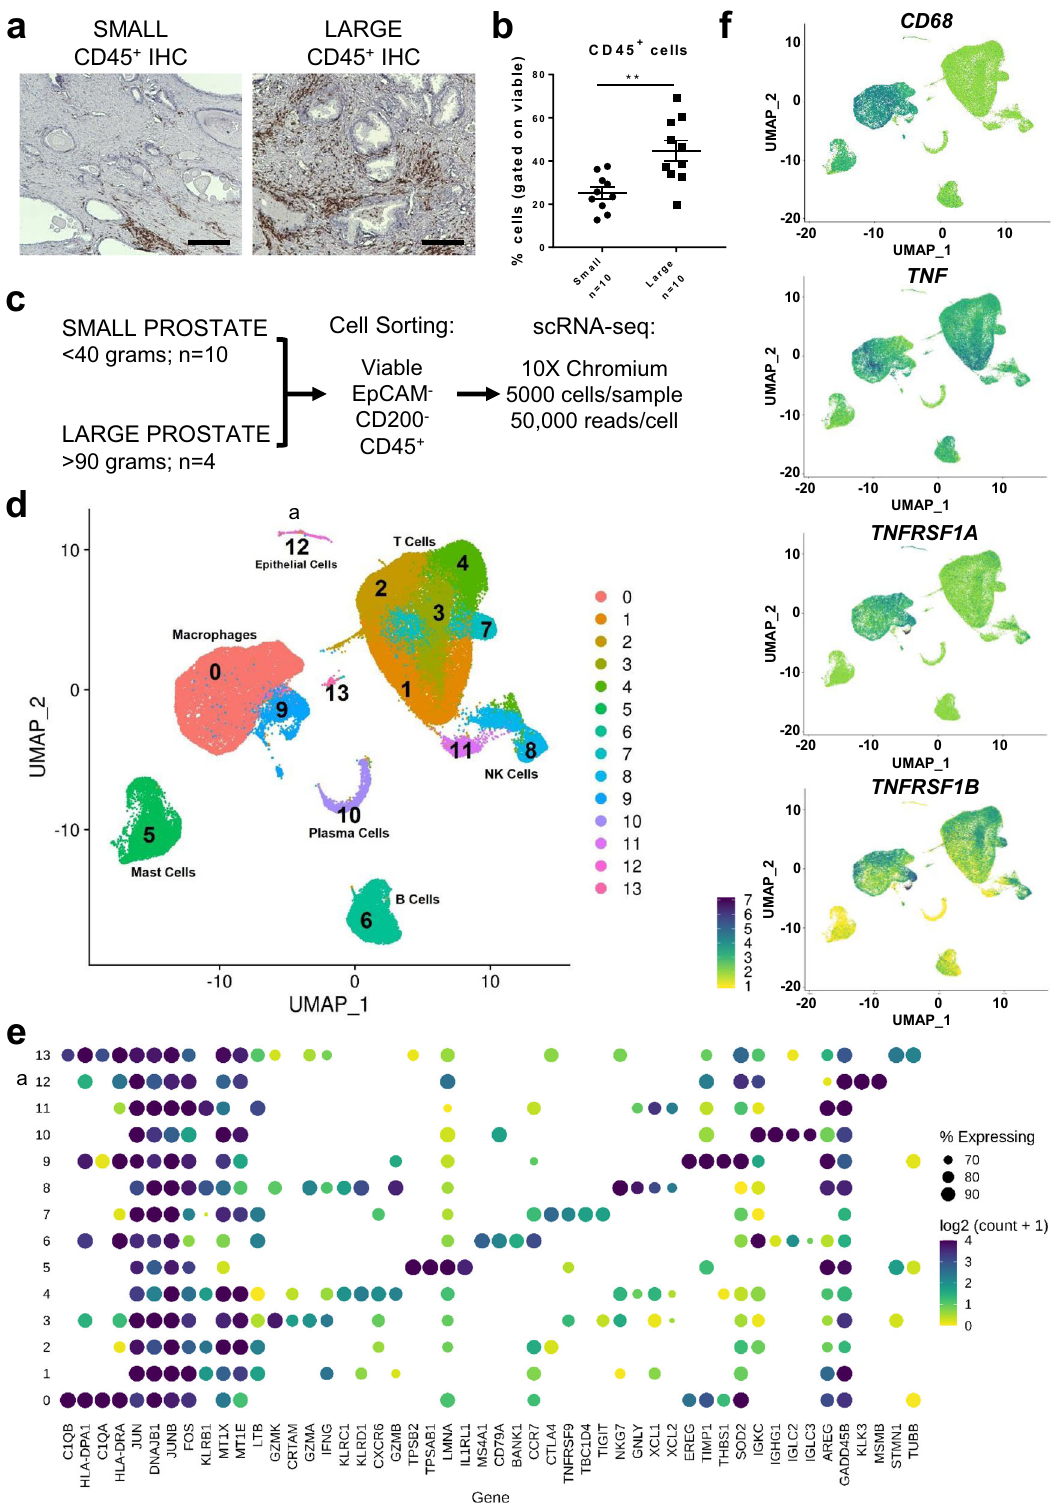
model analysis indicated that ventral prostate volume trended evaluation of prostate tissues following etanercept treatment indicated signi fi cantly diminished epithelial cell proliferation